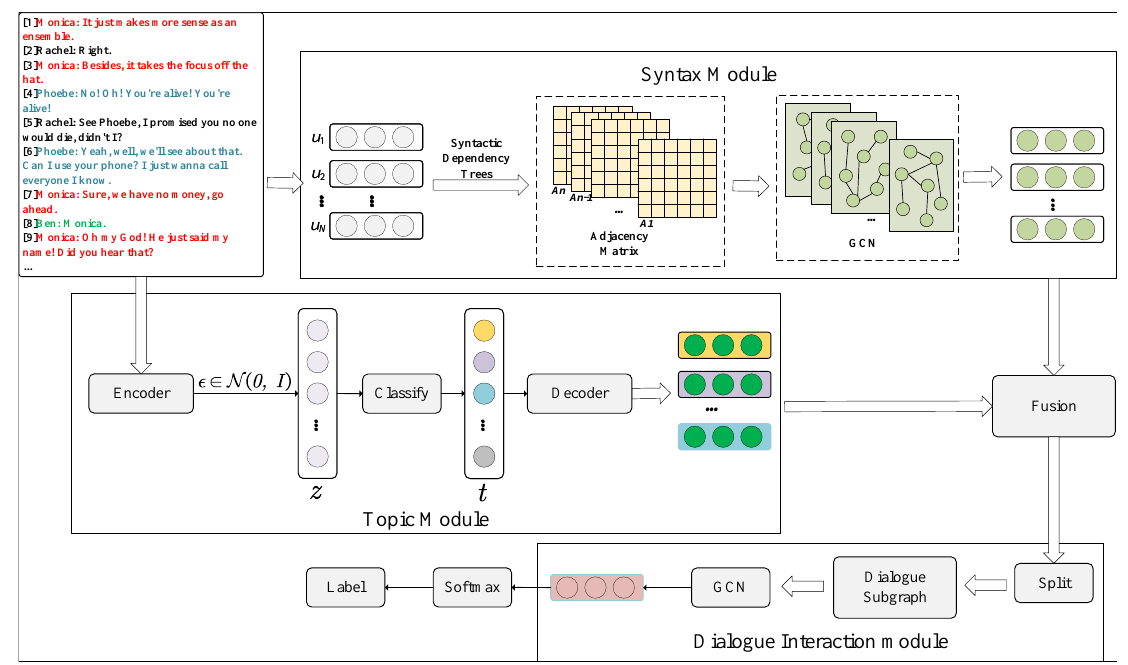
Figure 1. Overview of our proposed approach SETD-ERC, which consists of a syntax module, a topic module, and a dialogue interaction module. Syntax module and topic module integrate dependency parsing with GCN and topic feature extraction to enhance the representation of the sentence. The dialogue interaction module incorporates topic segmentation and draws dialogue graphs to imitate emotional